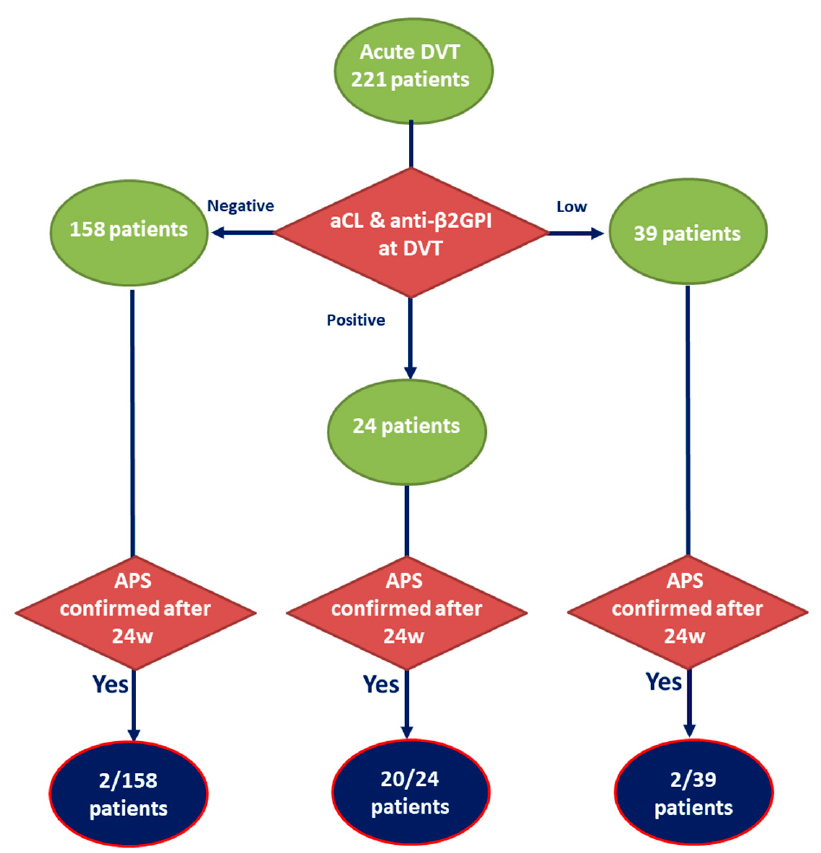
Figure 1. Schematic representation of participants’ aPL positivity according to diagnostic importance at the time of deep venous thrombosis (DVT) and number of patients who fulfilled current APS classification criteria 24 weeks (w) after DVT in each group. Negative: below detection limit; low: criteria aPL present between 95th and 99th percentile of healthy control population; positive: criteria aPL above 99th percentile of healthy control population. The majority of APS patients (17/24, 71%) were single positive for aCL IgG, anti- β 2GPI IgG or aCL IgM (Figure 2). Four patients (17%) were double positive for aCL IgG and anti- β 2GPI IgG, one patient (4%) was double positive for aCL IgM and anti- β 2GPI IgG, two patients (8%) had LA. One double positive patient, additionally, had anti- β 2GPI IgM and low level aCL IgM; three double positive patients, additionally, had non criteria anti- β 2GPI IgA present. One of the LA positive APS patients had persistently positive non criteria aPS/PT antibodies as